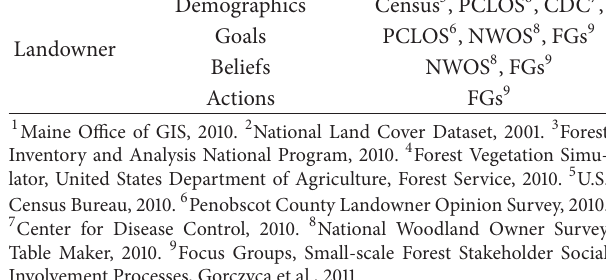
Table Maker, 2010. 9 Focus Groups, Small-scale Forest Stakeholder Social Involvement Processes, Gorczyca et al.,